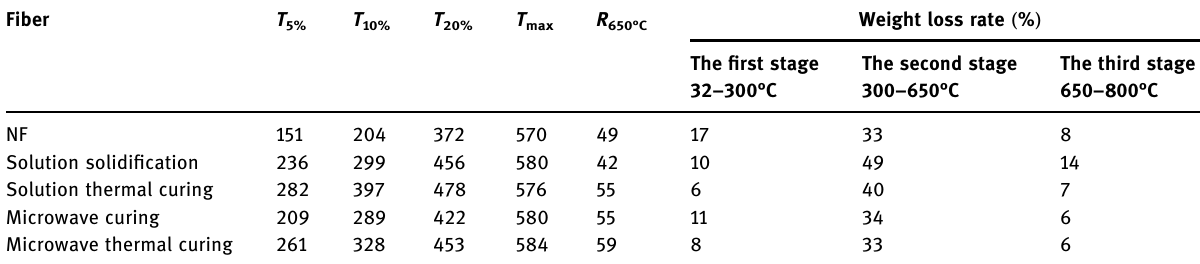
Table 3: TGA data of di ff erent phenolic fi bers in N 2 atmosphere